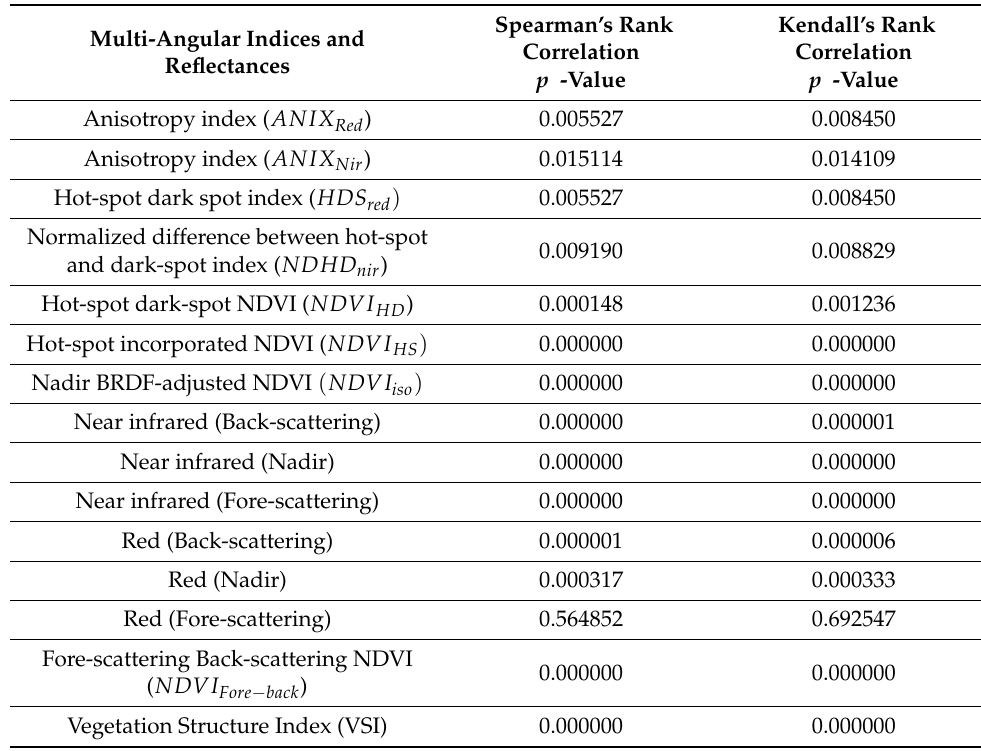
Table 3. Calculation of nonparametric rank correlation p -values. Multi-Angular Indices